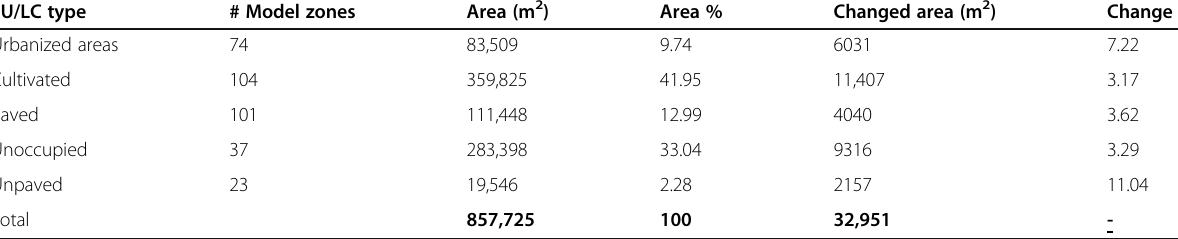
Table 2 Summary of the LU/LC areas of change and their percentages LU/LC type # Model